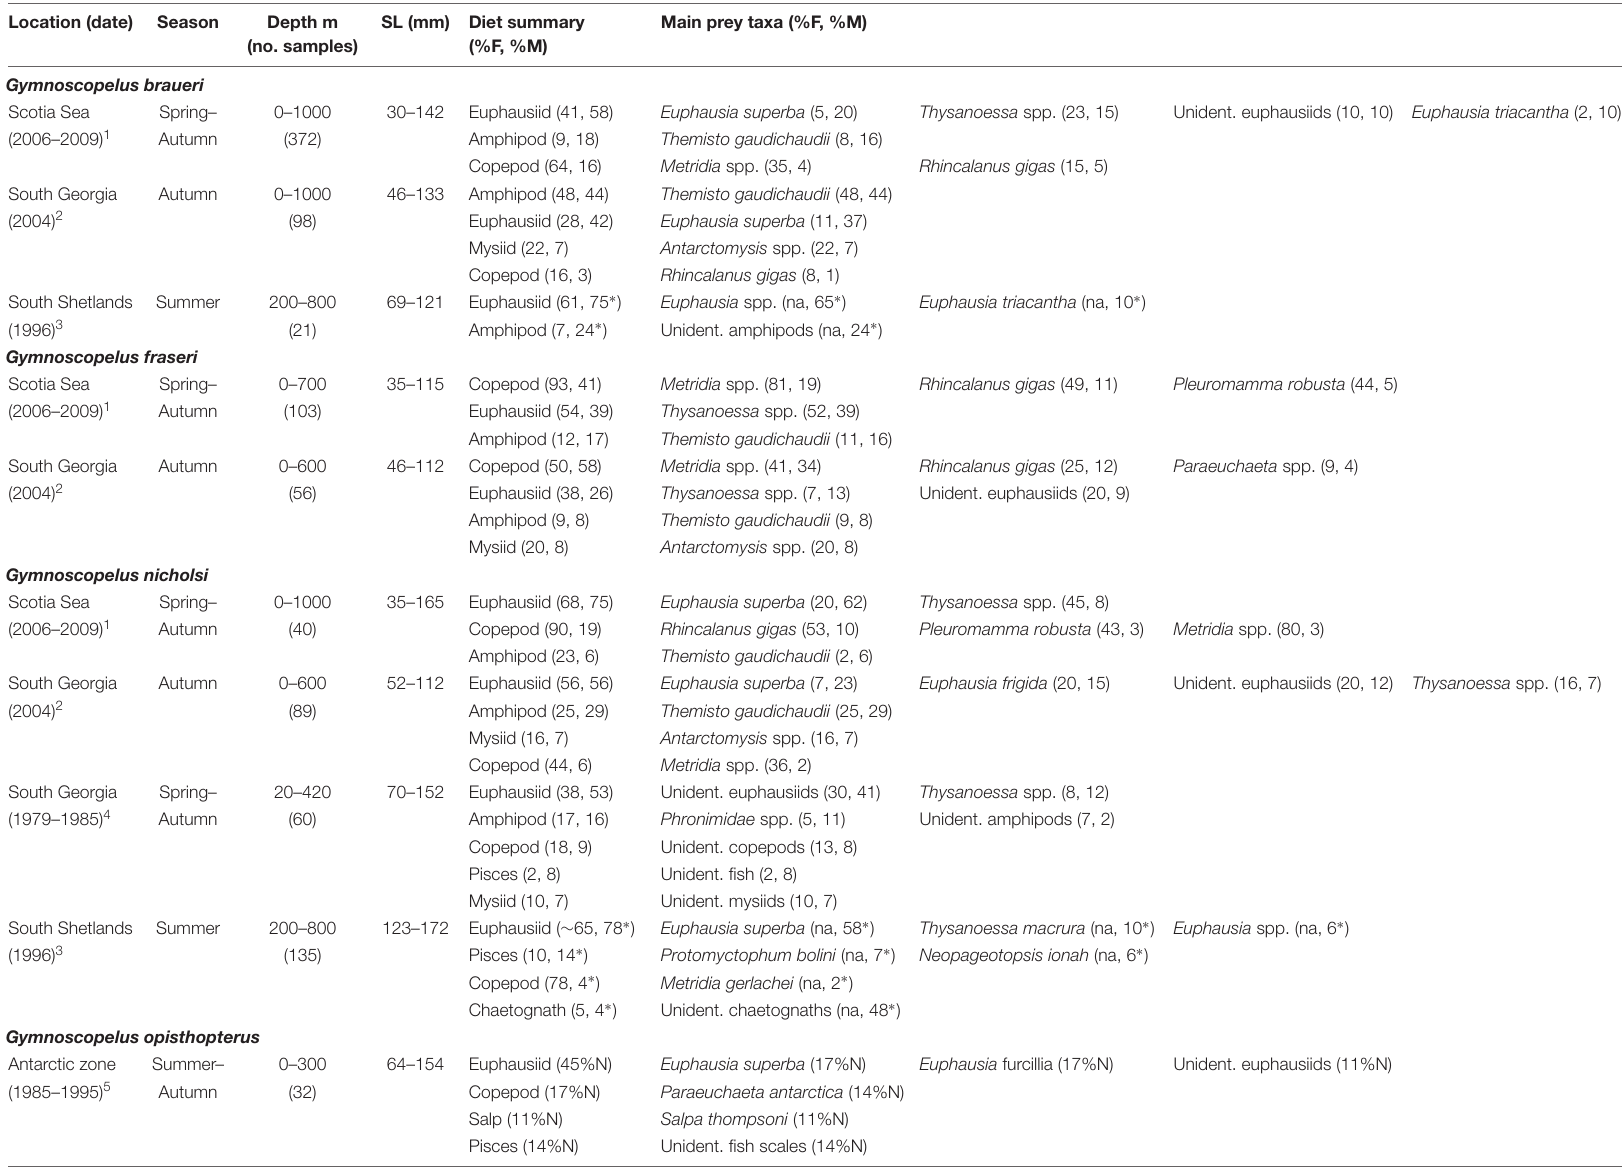
TABLE 3 | Diet of Gymnoscopelus braueri , Gymnoscopelus fraseri , Gymnoscopelus nicholsi , and Gymnoscopelus opisthopterus in the Scotia Sea expressed by percentage frequency of occurrence (%F) and percentage mass (%M). Location (date) Season Depth m SL (mm) Diet summary Main prey taxa (%F, (no. samples) (%F, %M)